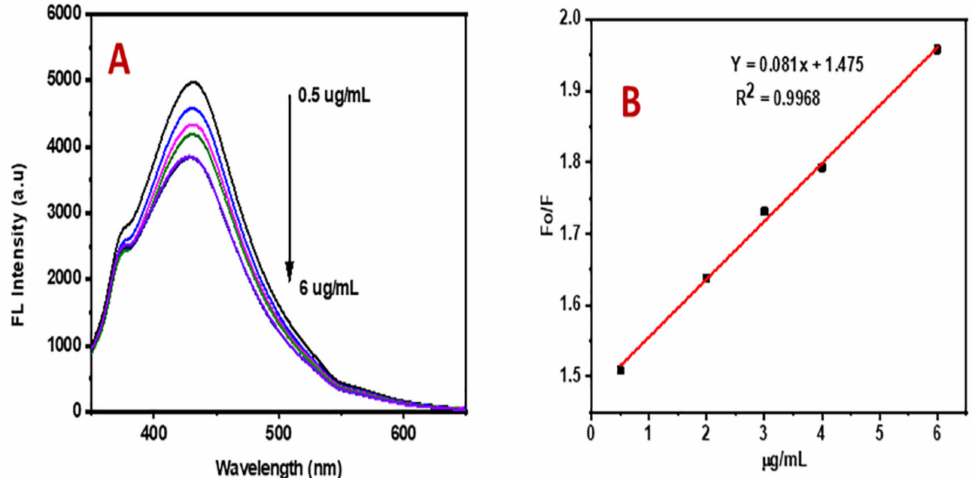
Figure 6. ( A ) FL emission spectra of PC-CDs at a wavelength of 430 nm, in the presence of different concentrations of Cu 2+ from 0.5 to 6 µ g/mL; ( B ) linear relationship response plot of synthesized PC-CDs and different concentrations of Cu 2+